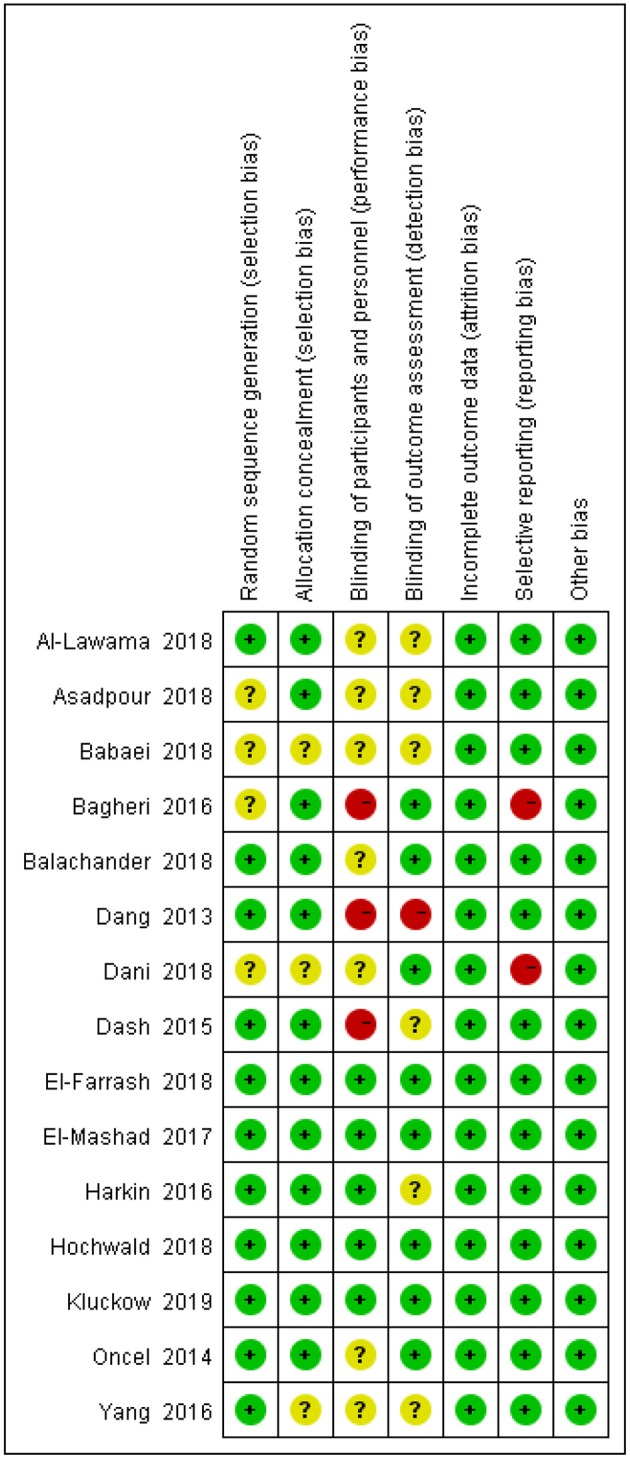
Results of the risk of bias.